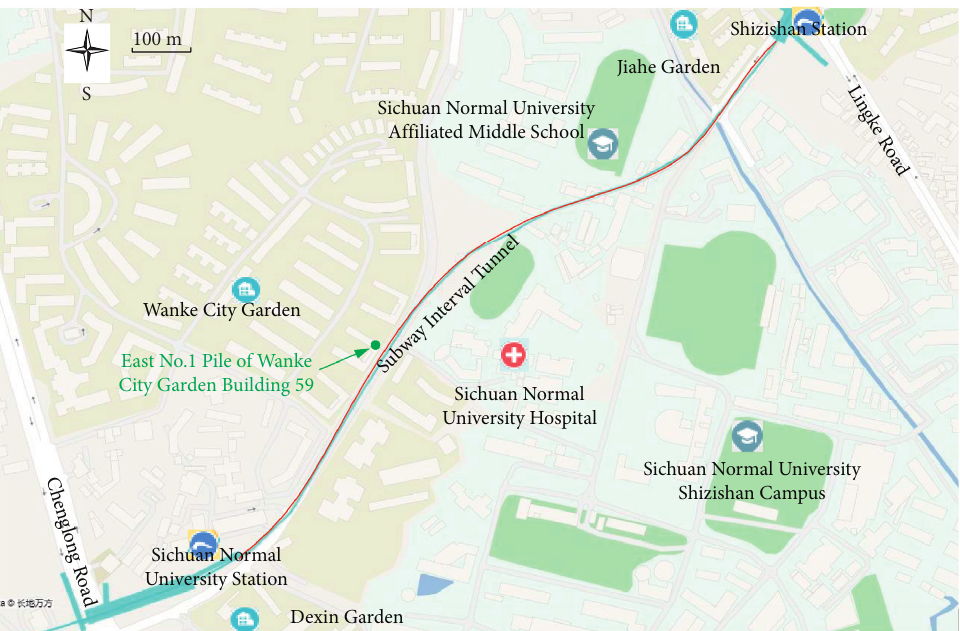
Figure 1: The location of the interval tunnel.